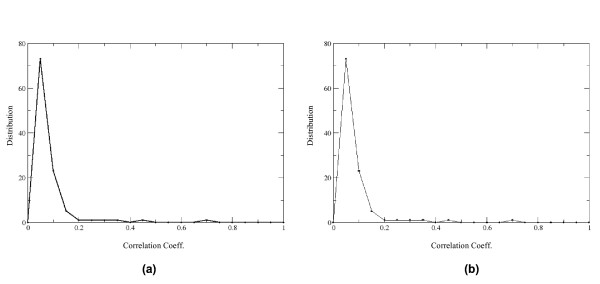
310–450 K Correlation coefficient Superposition. Distributions of the correlation coefficients of the superposition between the first eigenvector at 310 K and all the eigenvectors at 450 K for PrP (a) and Dpl (b).